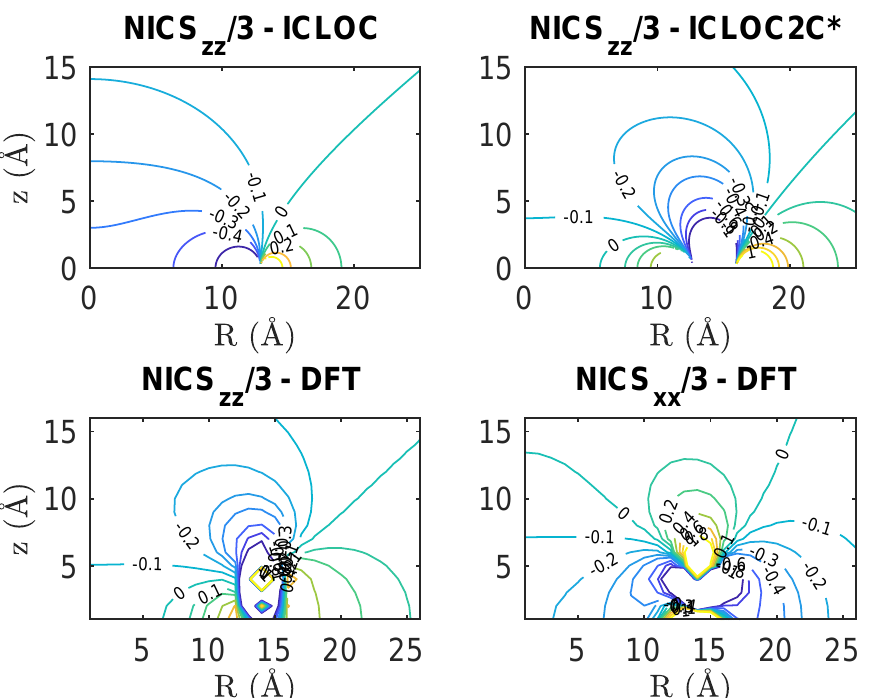
Figure 6. Contributions NICS zz /3 to the isotropic NICS, coming from the ICLOC model ( top-left ), from the ICLOC2C* model ( top-right ), and from a two-dimensional scan at the BHandHLYP/6-31G* level ( bottom-left ). The contribution to the isotropic NICS coming from the component perpendicular to a porphyrin computed at the same level is also shown ( bottom-right